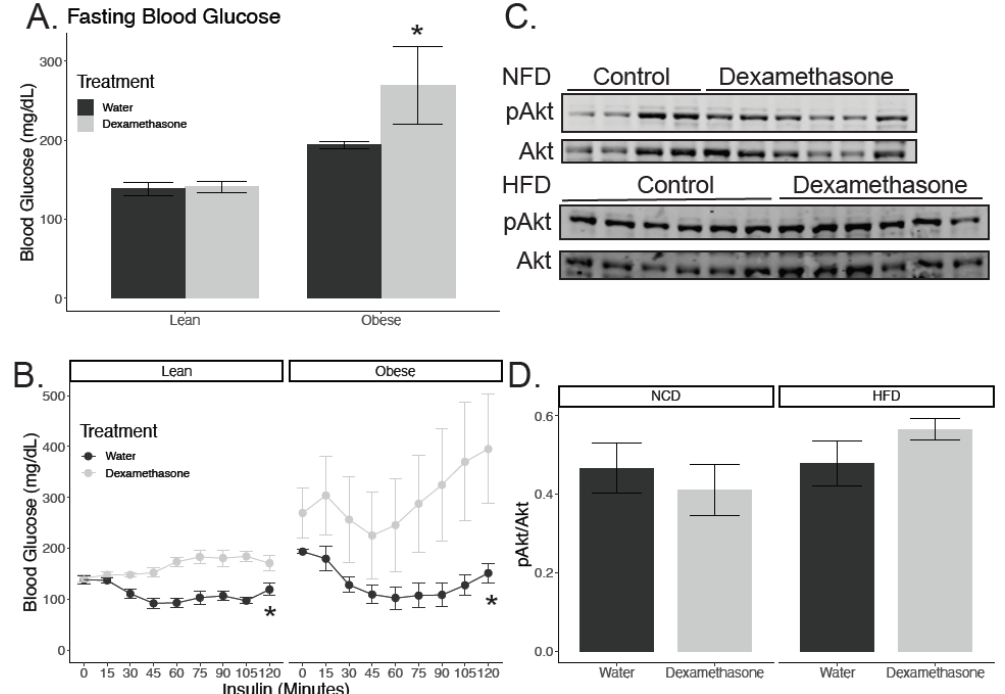
Figure 4. Dexamethasone treatment induces insulin resistance. Blood glucose values from lean and obese male mice after a six-hour fast and two weeks of dexamethasone or vehicle (water) treatment ( A ), followed by insulin injection ( B ). n = four mice per group. Insulin was given via intraperitoneal injection at 0.75 g/kg lean mass for lean mice and 1.5 g/kg for obese mice (n = four mice per group). ( C ) Representative western blotting of quadriceps lysates from NCD or HFD animals treated with water or dexamethasone. ( D ) Quantification of pAkt/Akt from samples described in ( C ). Asterisks indicate a significant interaction between diet and treatment by two-way ANOVA ( A ) or mixed linear models ( B ) analyzed separately for lean and obese mice.